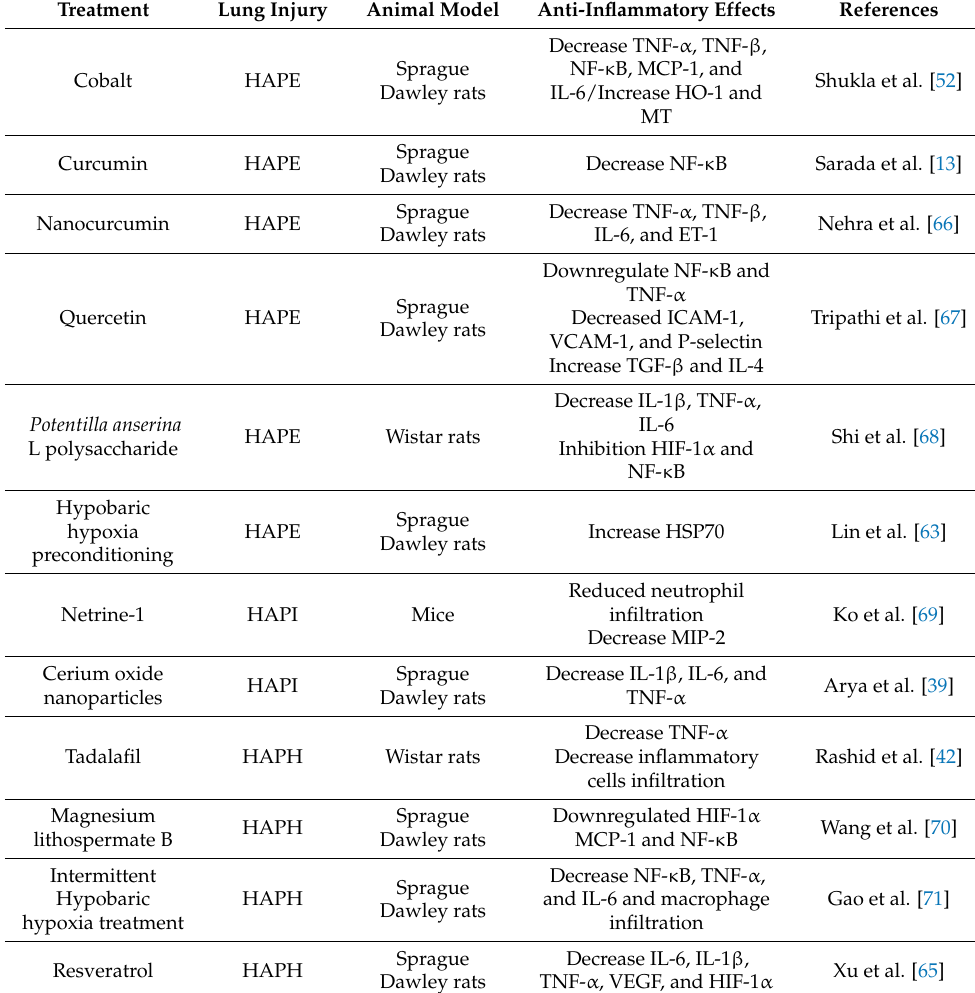
Table 1. Anti-inflammatory treatments for lung alterations due to hypobaric